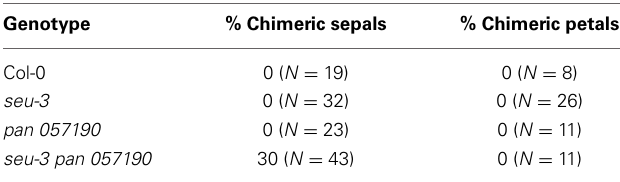
Table 3 | Chimeric floral organs in seu pan double mutants under short-day